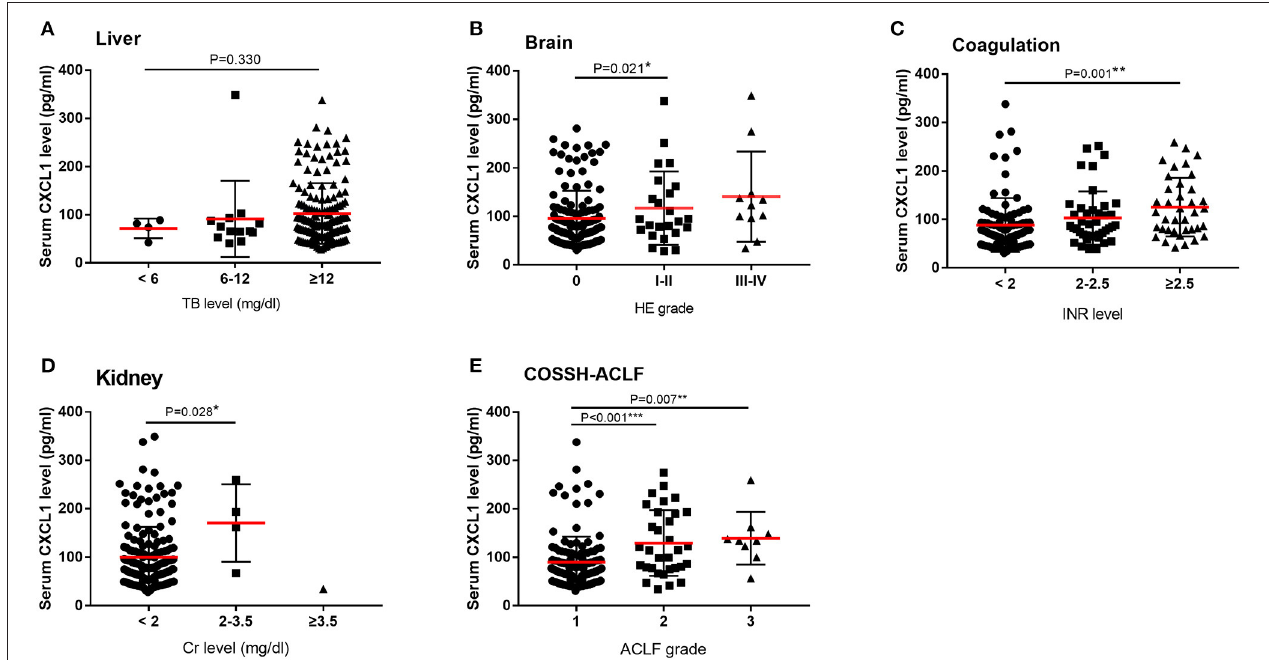
FIGURE 3 | Serum CXCL1 levels and organ injury among patients with HBV-ACLF. Comparisons of serum CXCL1 levels among patients with various degrees of organ injury according to CLIF-OF score and COSSH score. (A) liver (B) brain (C) coagulation (D) kidney (E) ACLF grade. * P < 0.5; ** P < 0.01; *** P <